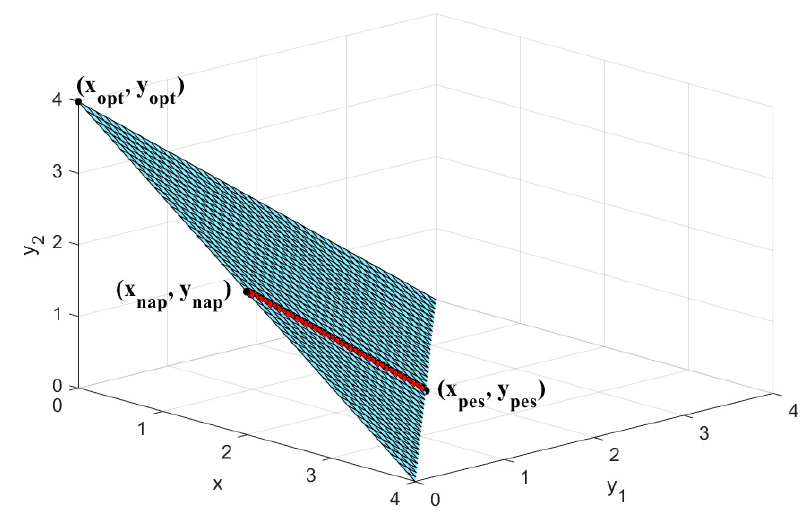
Figure 1. The inducible region IR and IR d of Example 1.